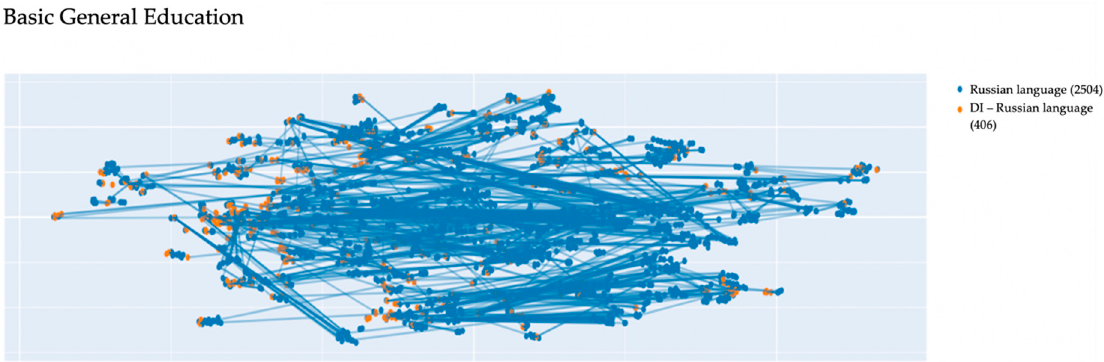
Figure 3. Semantic correlations between the didactic item titles in the topical framework and the lesson script titles in the subject Russian language.